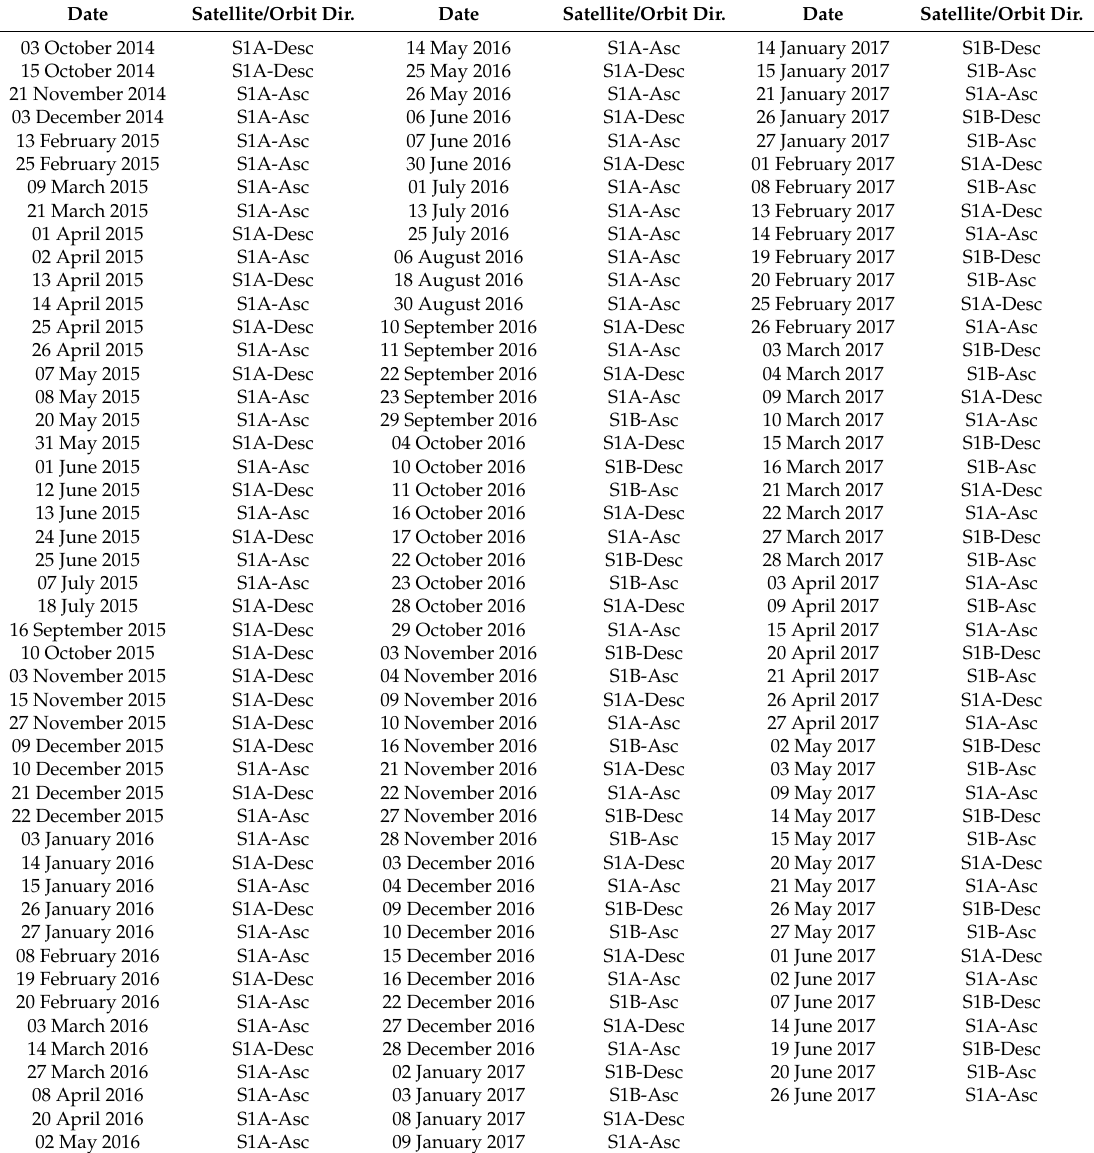
Table 1. Sentinel-1’s SAR observations from descending orbit (5:43 UTC) and ascending orbit (17:30 UTC) used in this study over three snow seasons 2014–2015, 2015–2016 and